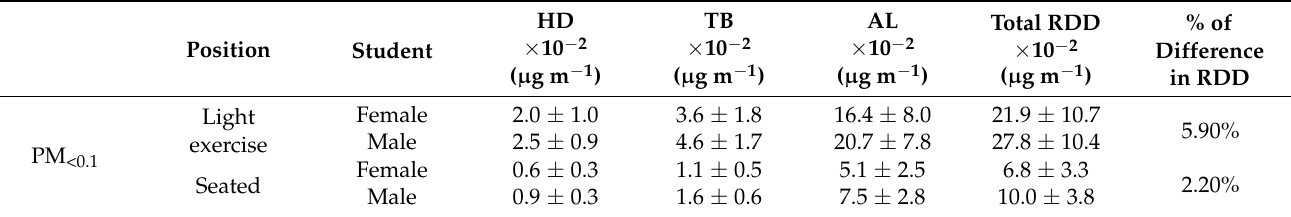
Table 8. Descriptive characteristics while sitting or during light exercises and Mean-difference (%) in RDD between the male and female students for different PM size stages. The mean-difference value for RDD is calculated using male student’s RDD as a